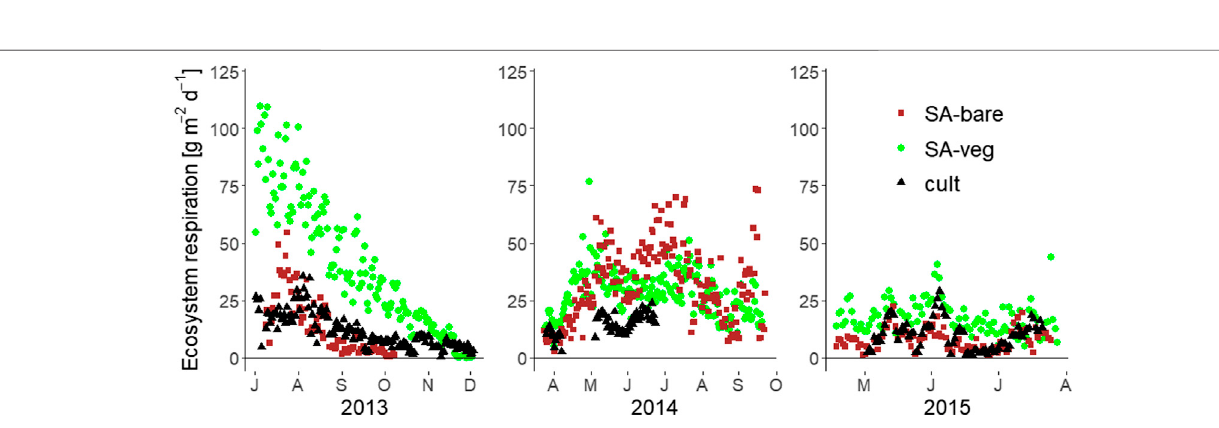
FIGURE 6 | Daily ecosystem respiration [g m − 2 ] measured by automatic chambers at the set-aside site (SA-bare and SA-veg) and the cultivated site (cult) in July-December 2013, April-October 2014, and May-August 2015.